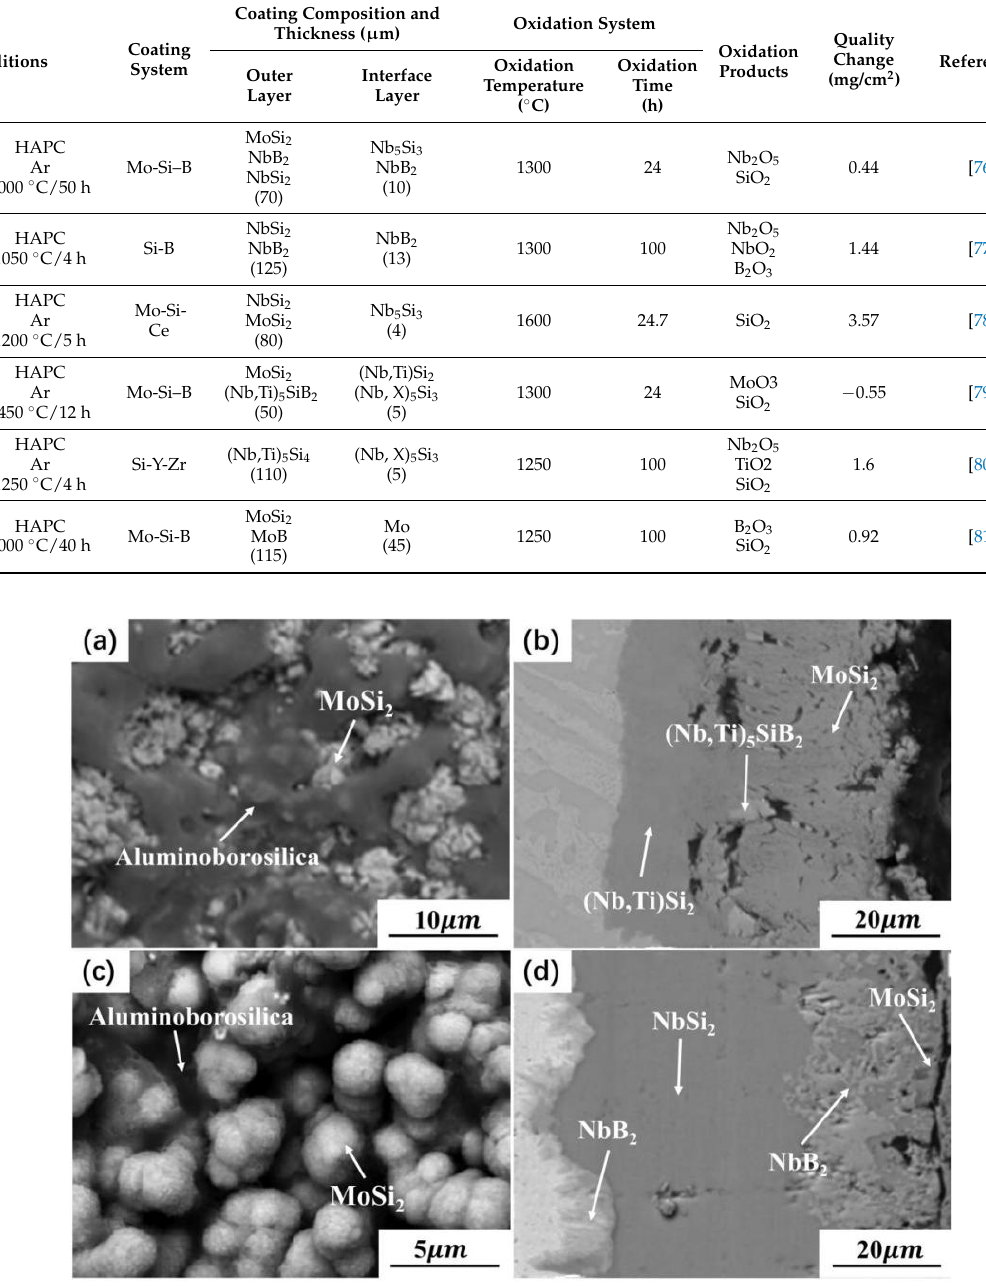
Figure 10. Typical SEM of two-step method coatings. ( a , b ) Mo-Si-B coating prepared by SPS (spray distance:100 mm, spray rate: 20 g/min) + HAPC (1000 °C/50 h) process; ( c , d ) Mo-Si-B coating